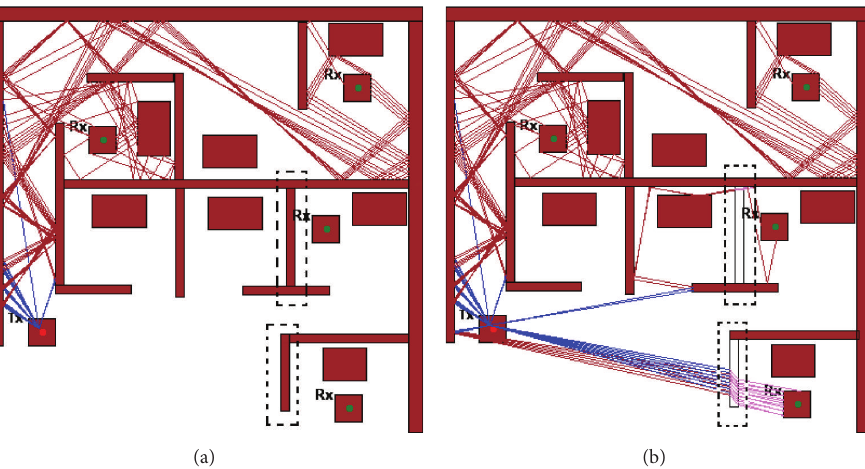
Figure 7: (a) Two blind spots exist in the coverage area when all partition walls to be considered are made of brick. (b) Blind spots are removed when some partitions are replaced by the glass